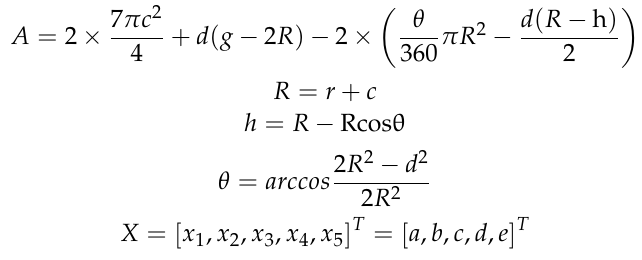
Figure 16. Result of parameters sensitivity analysis.